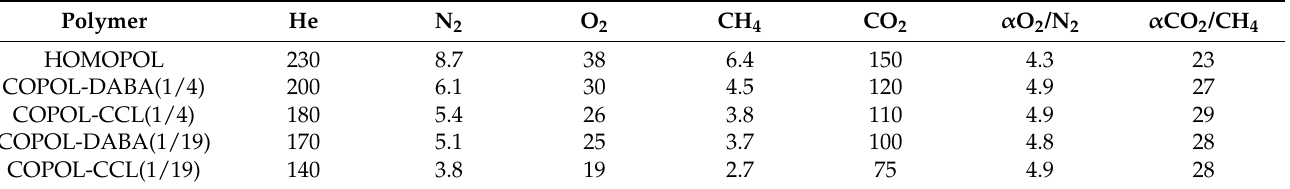
Table 7. Permeability (P) and ideal selectivity ( α ) coefficients for linear and crosslinked copolyimides (measurement conditions: 3 bar at 35 ◦